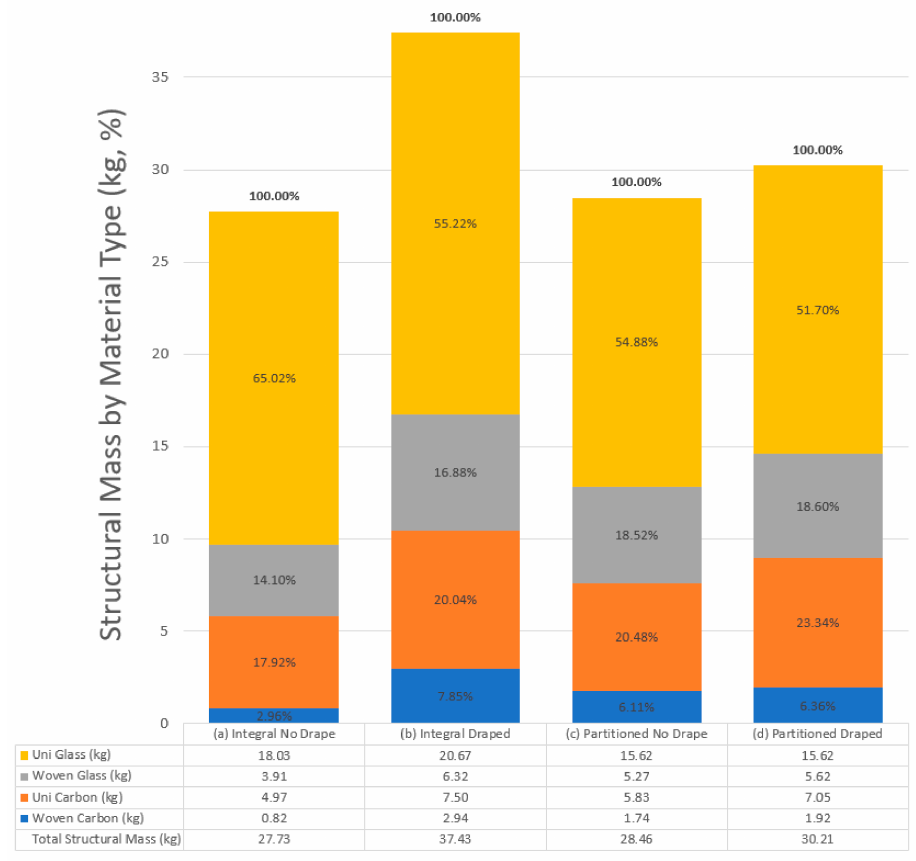
Figure 12. Comparison of optimized structural masses by material type for the four designs.